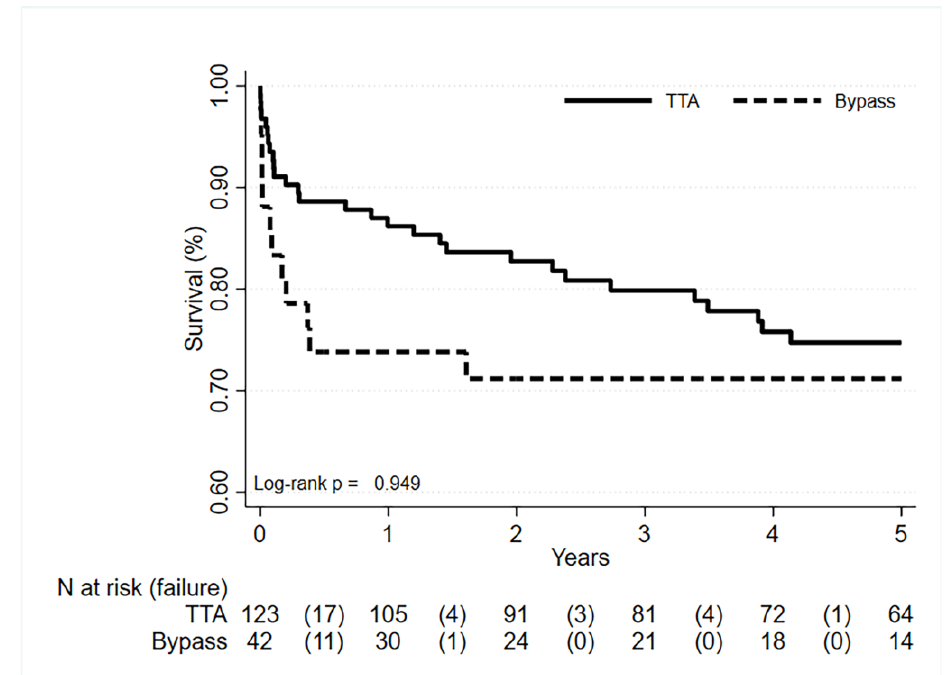
Figure 3. Kaplan–Meier survival analysis of the two groups TTA and bypass.